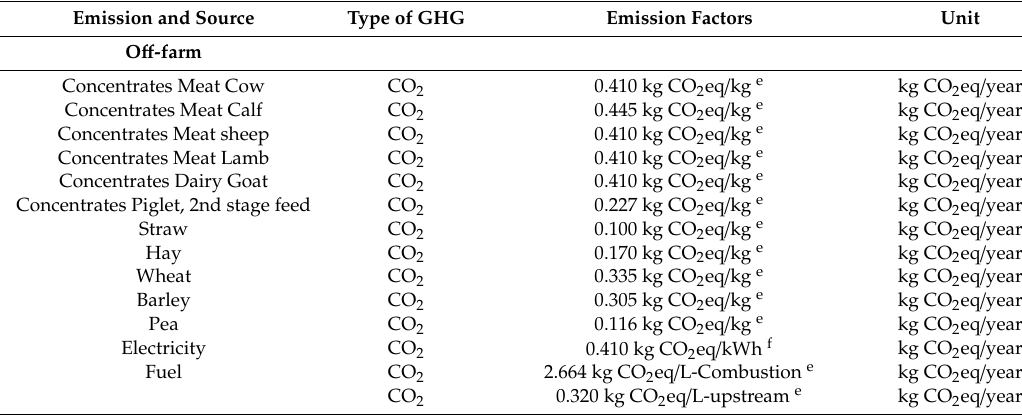
Table 2. Emission factors used to quantify greenhouse gas emissions